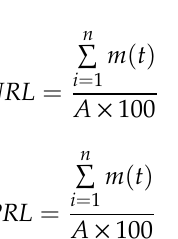
Figure 2. Artificial rainfall experiments on a runoff plot.